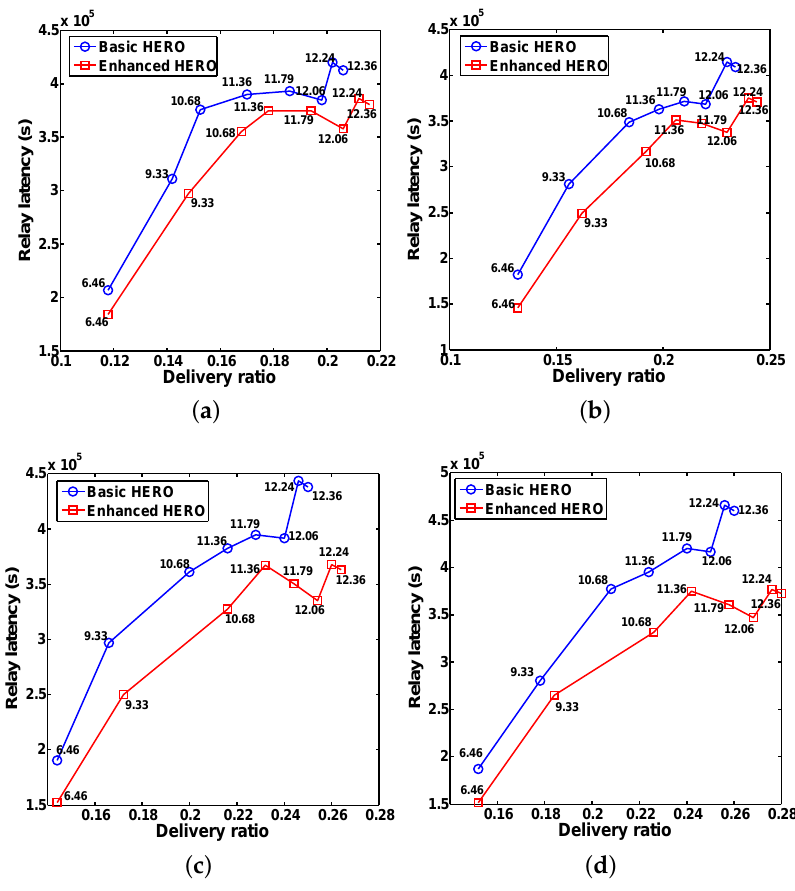
Figure 9. The delivery ratio and the relay latency under different average home size. The figure shows when the average home size equals 12.06, the best performance of both HERO algorithms can be obtained. ( a ) U = 300; ( b ) U = 400; ( c ) U = 500; ( d ) U =